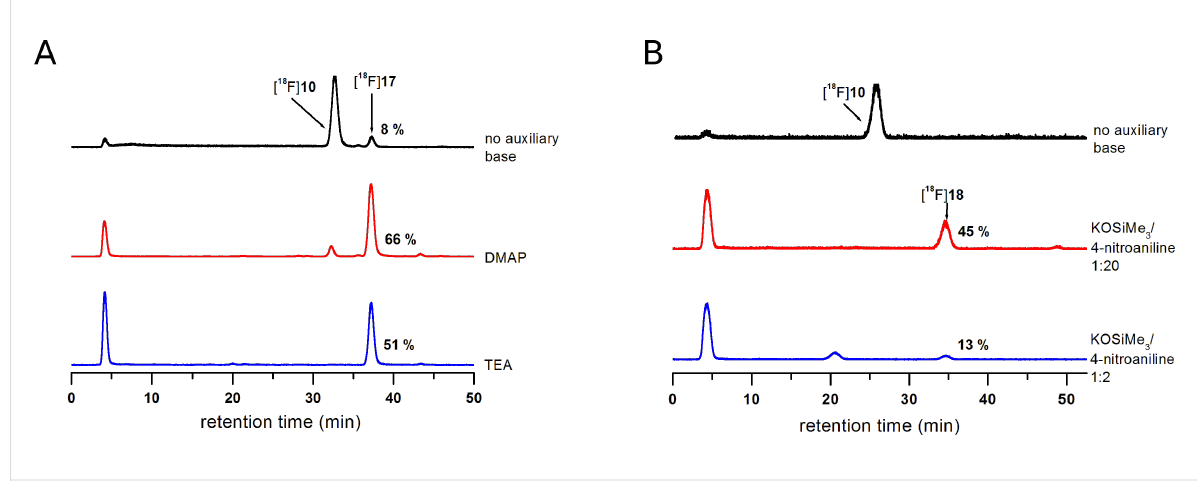
Figure 5: Radio-HPLC chromatograms for the reaction of [ 18 F] 10 with (A) 4-fluoroaniline in the absence and presence of 4- N , N -dimethylaminopyri- dine (DMAP) and triethylamine (TEA) and (B) 4-nitroaniline in the absence and presence of potassium trimethylsilanolate in varying amounts relative to the nucleophile. The ordinates (counts of 18 F-activity in arbitrary units) are omitted for clarity.